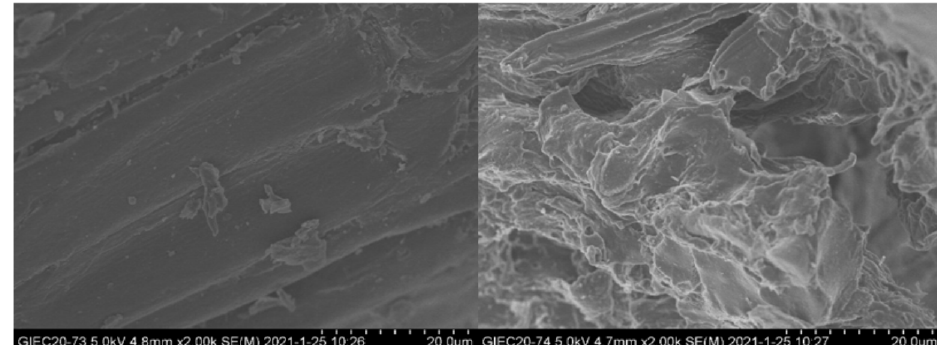
Figure 1. SEM images of raw corn straw (CS) and pretreated